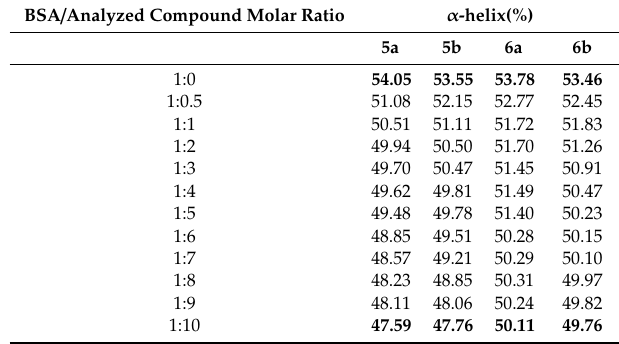
Table 7. The values of calculated α -helix(%) for BSA with the absence and presence of all analyzed compounds.